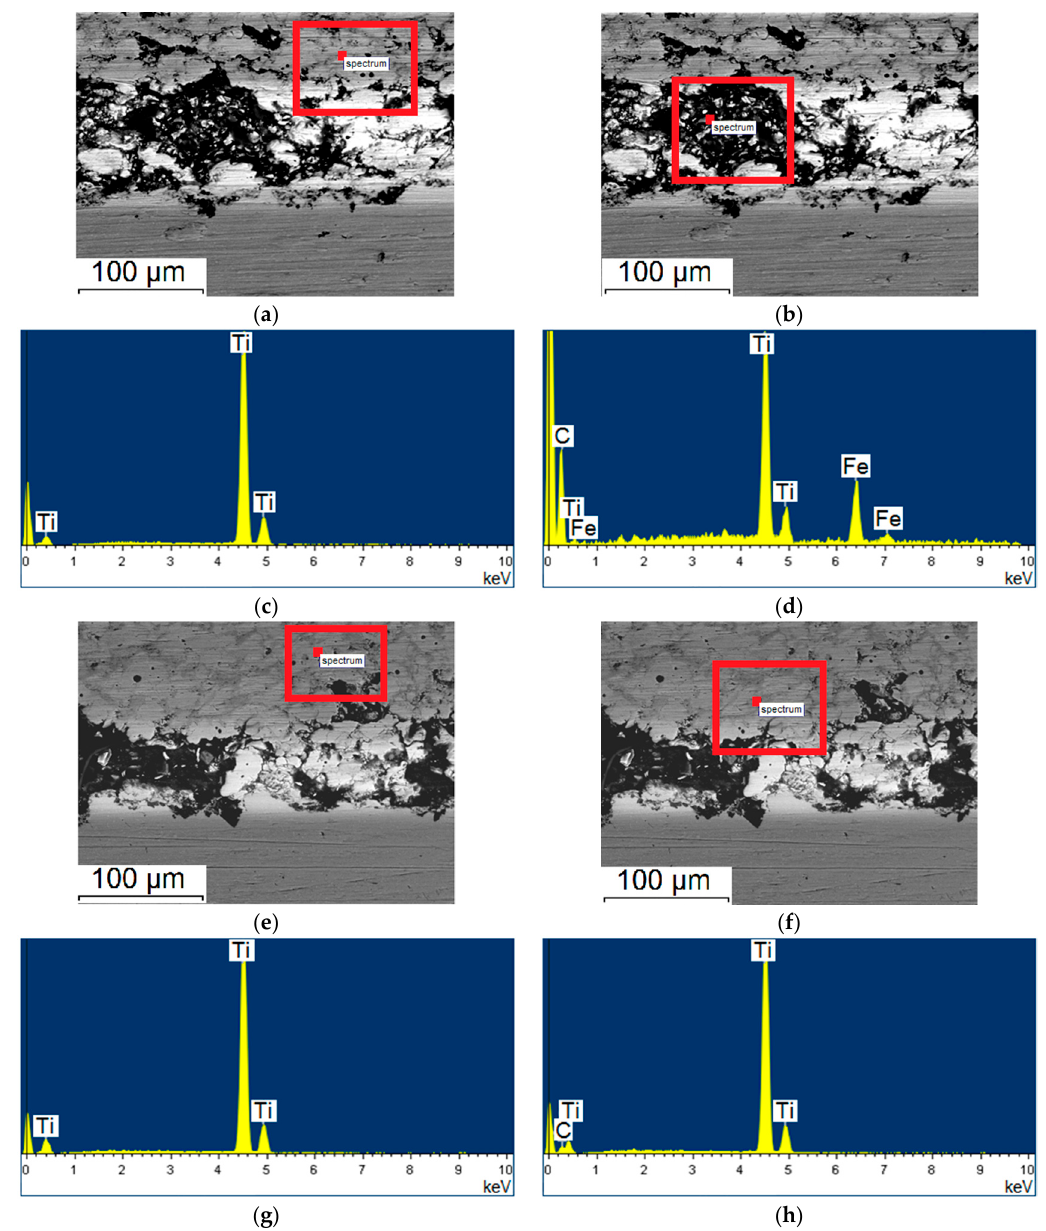
Figure 5. Micrographs of the coating cross-section and EDS results: specimen produced in regime No. 3 ( a – d ) and No. 4 ( e – h ). A circle within red rectangle shows the location where EDS analysis was carried out.